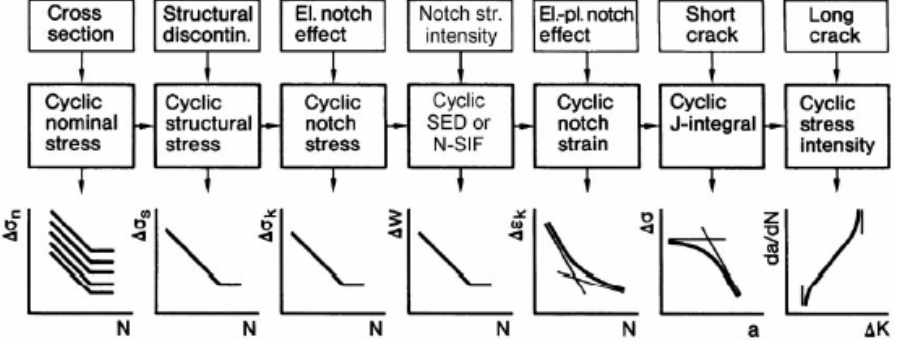
Figure 13. Global and local approaches for fatigue assessment of welded joints [26].